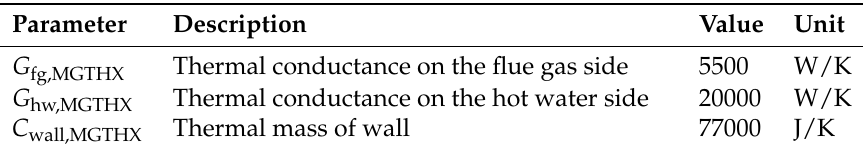
Table 4. Parameters of the MGTHX grey box model.